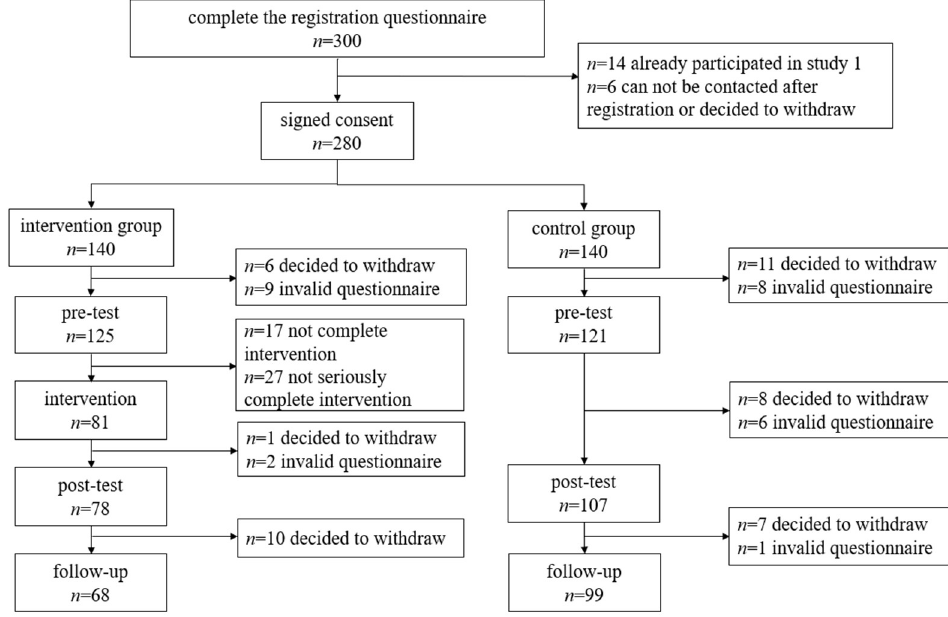
Figure 3. CONSORT flow diagram.